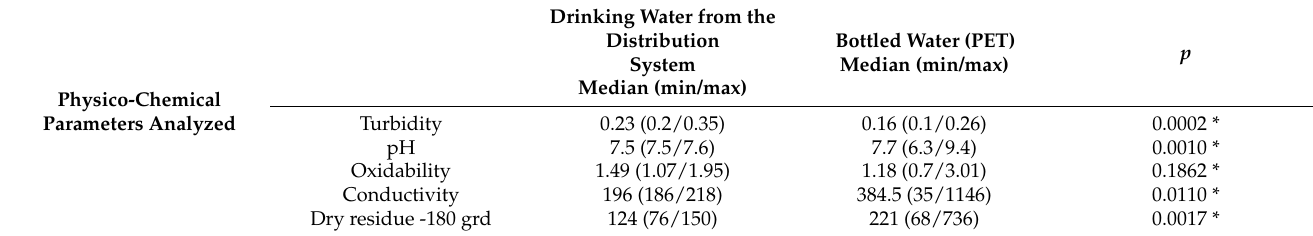
Table 2. Physical and chemical parameters for main’s water vs. bottled